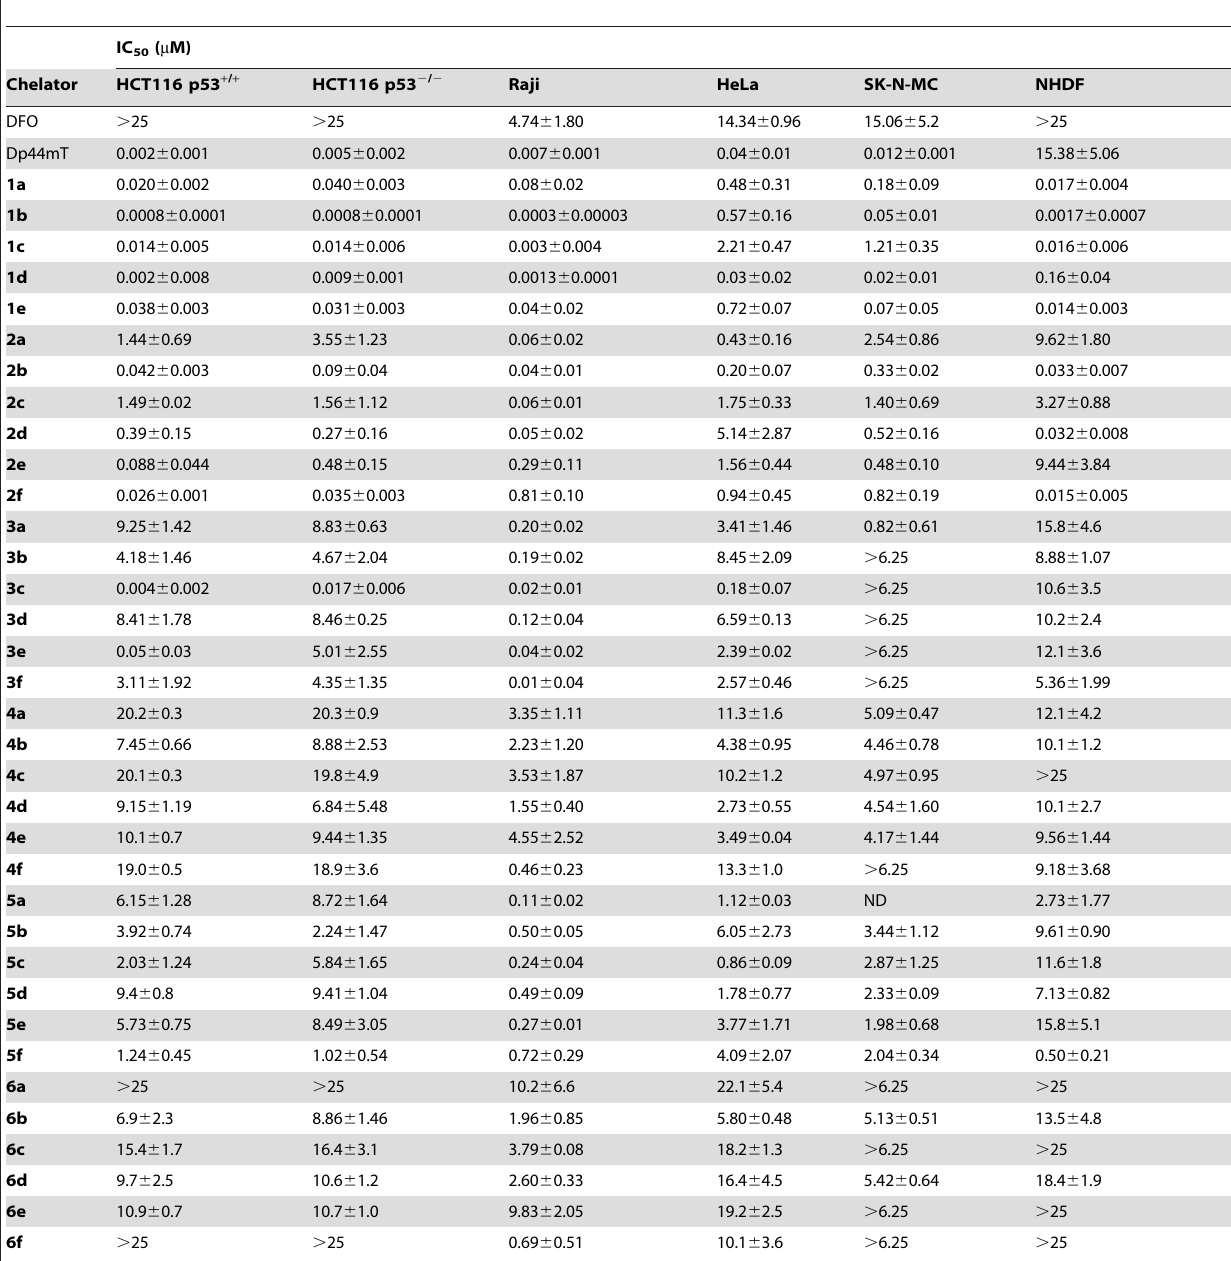
Table 1. Anti-proliferative activity (IC 50 values) of the novel thiosemicarbazones in comparison to DFO and Dp44mT in several tumor cell-types and normal human dermal fibroblast (NHDF)